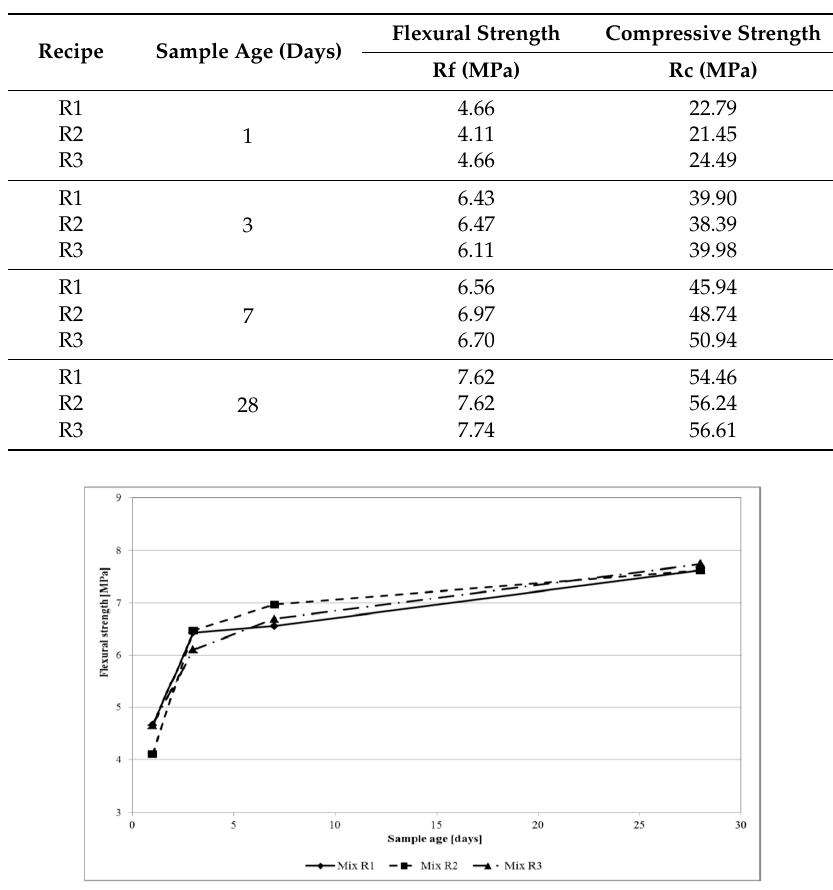
Figure 3. Values of flexural strength.